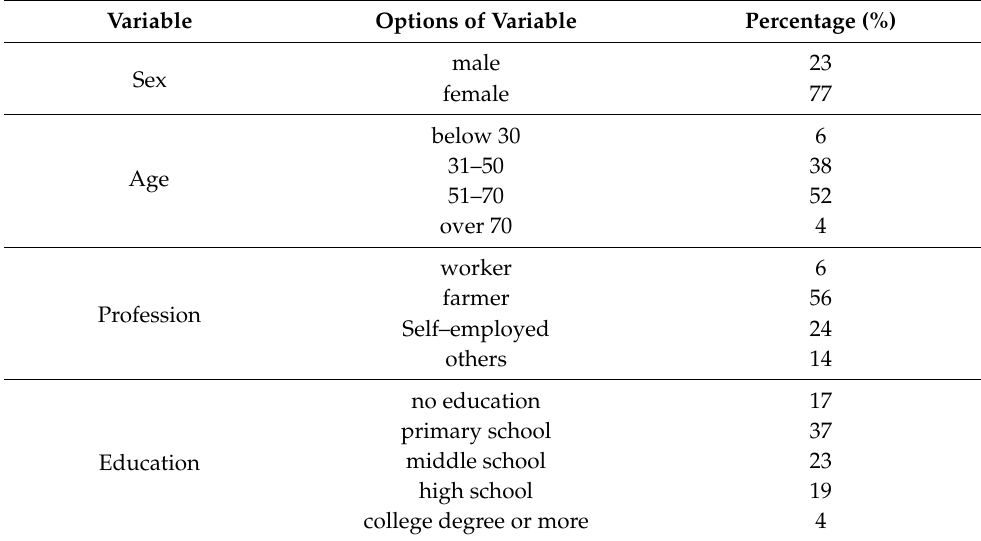
Table 3. Demographic characteristic of surveyed respondents.